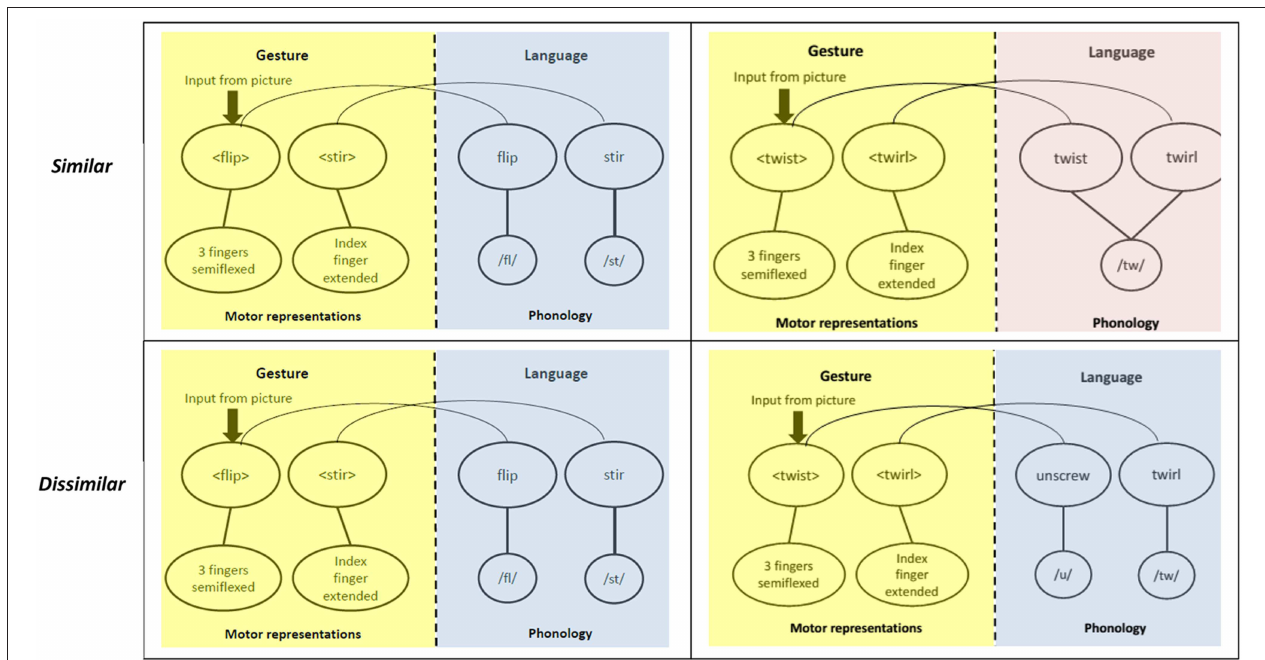
FIGURE 3 | The rationale of the study. The first row shows the similar and the second row, the dissimilar condition. The yellow panels show a schema of the process of mapping semantics (from pictures) to motor movements in gestures. The blue and pink panels show a part of the language production system that maps abstract word representations onto their phonology. The three blue panels are similar in that there is no overlap in the word onsets. The pink panel, on the other hand, contains words that share onset